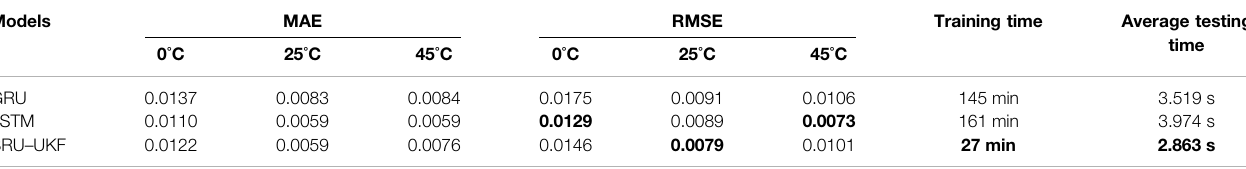
TABLE 3 | Comparison of SOC estimation among GRU, LSTM, and SRU – UKF at various ambient temperatures.